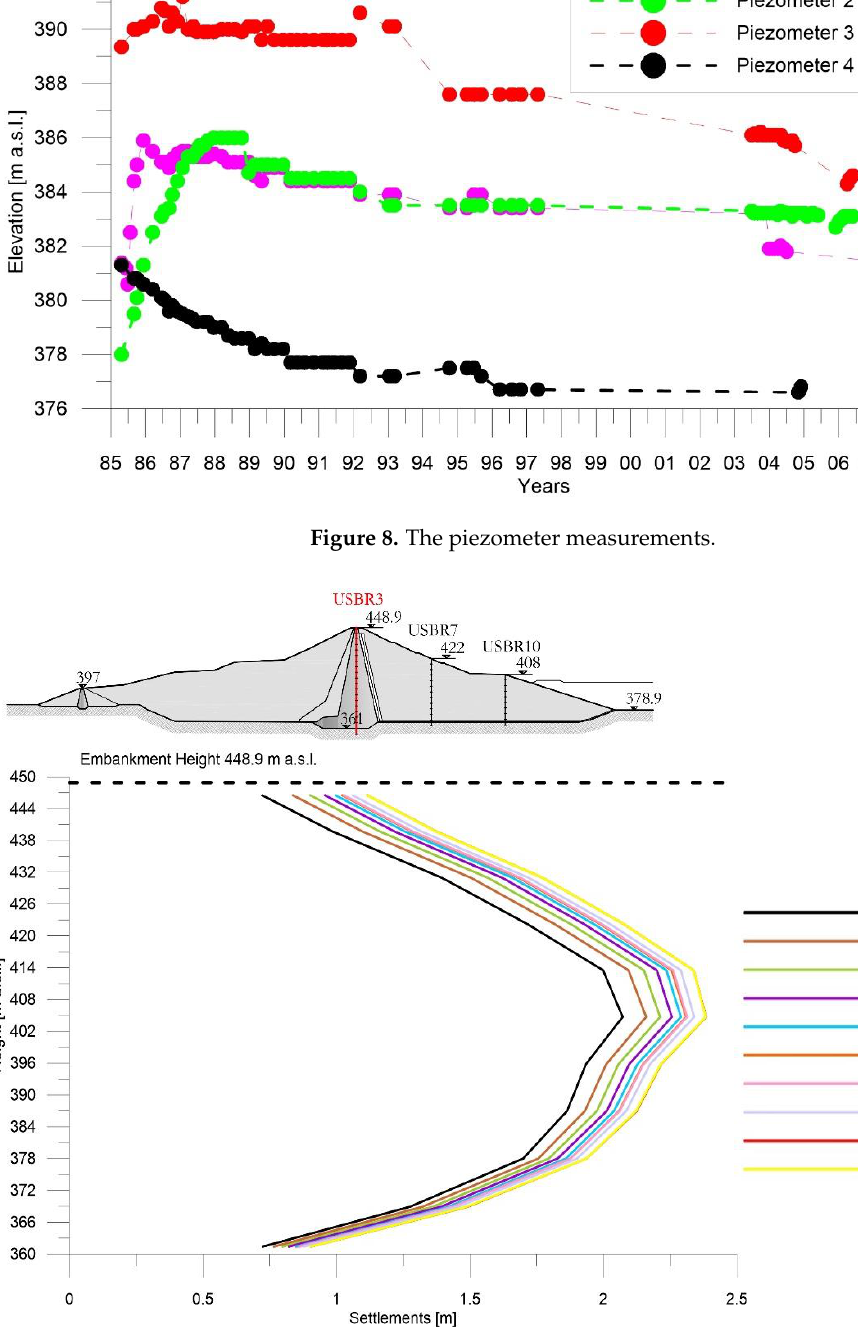
Figure 9. Extensometer USBR 3: settlement profiles during working phase.